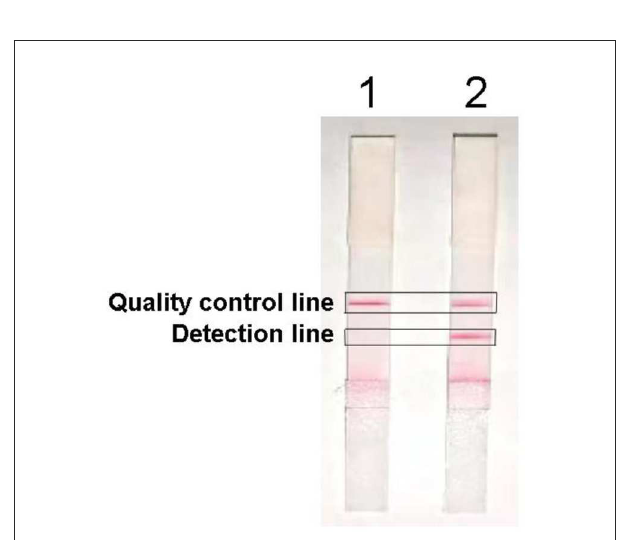
FIGURE2 Establishment of LAMP-LFD for H. pylori , lane 1: Negative control; lane 2: sample